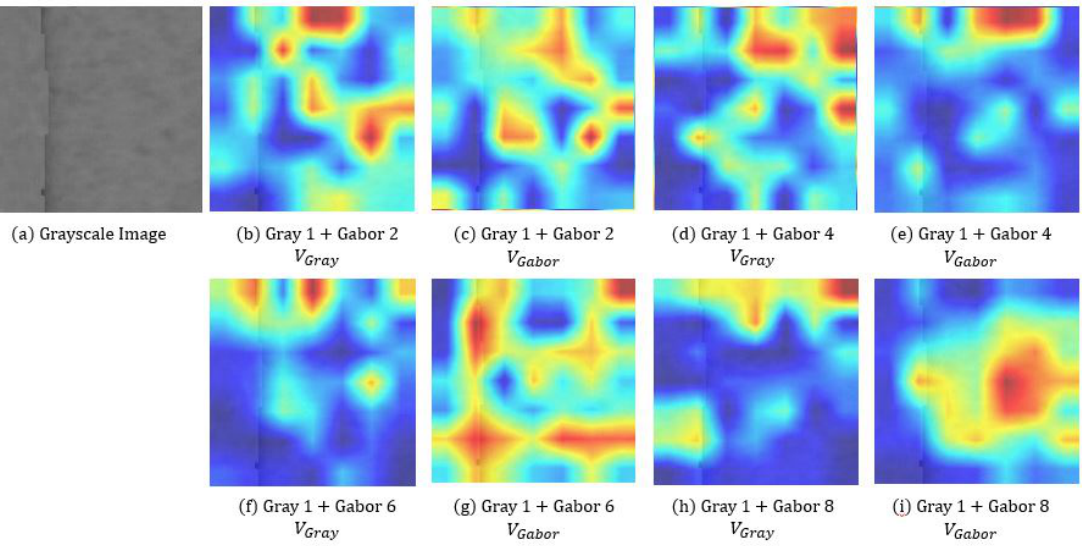
Figure 11. CAM image result for CCM OK image in a Dual-stream